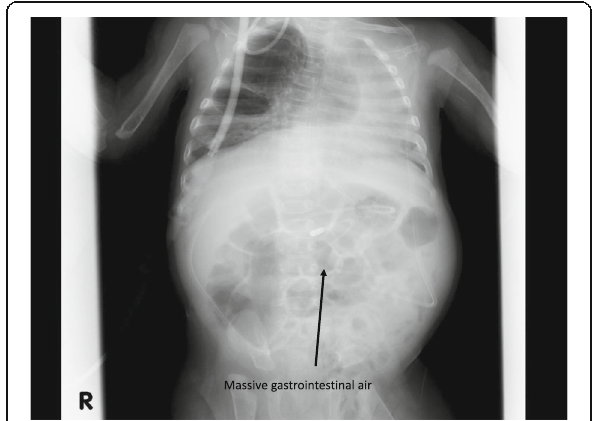
Fig. 3 A chest-abdominal X-ray at deteriorated respiratory status. A subsequent chest-abdominal X-ray revealed that gastrointestinal air was severely